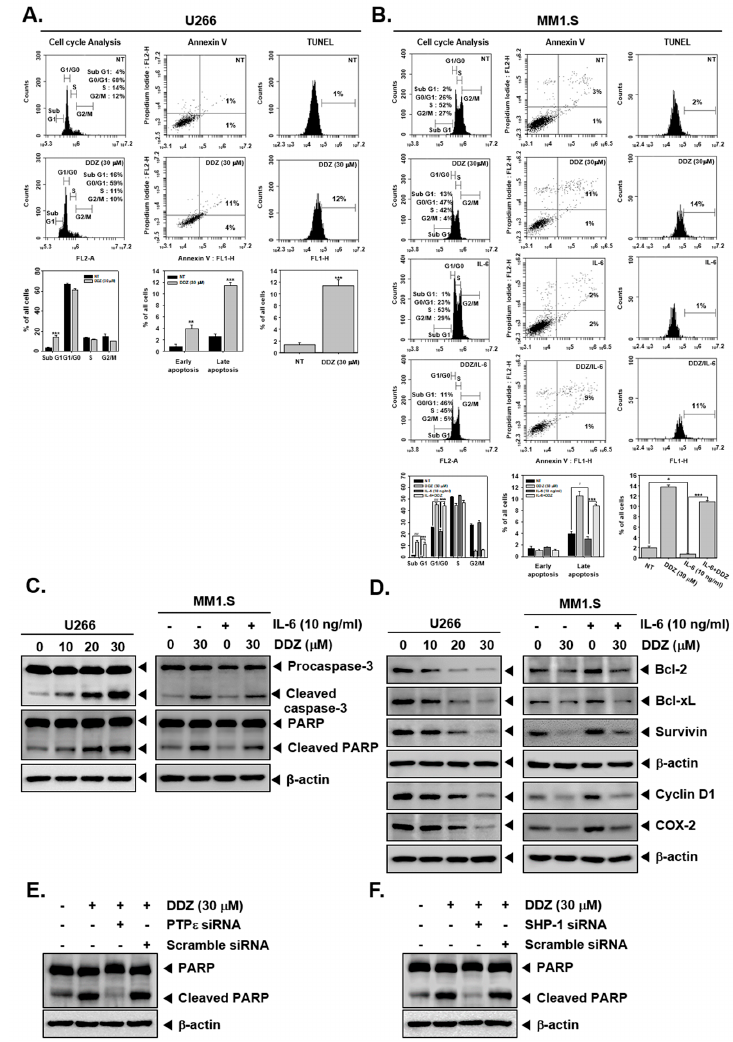
Figure 4. DDZ promotes apoptosis in multiple myeloma (MM) cells. ( A , B ) U266 cells were treated with 30 µ M of DDZ for 24 h, and MM1.S cells were treated with 30 µ M of DDZ for 24 h and stimulated with IL-6 (10 ng / mL) for 10 min. Cell cycle analysis: The cells were fixed with 100% ethanol, and cell cycle analysis was done using cytometry. Annexin V: cells were stained with Annexin V FITC and PI for 15 min before being analyzed by flow cytometry. TUNEL: The cells were fixed by 4% PFA (paraformaldehyde), stained with a TUNEL assay reagent, and analyzed with flow cytometry. The results are presented as the mean ± SD. ** p < 0.01, *** p < 0.001, # p < 0.05, ### p < 0.001 compared the control. ( C , D ) U266 cells (1 × 10 6 cells / well) were treated with indicated concentrations of DDZ for 24 h, and various proteins were examined by western blot analysis. MM1.S cells (1 × 10 6 cells / well) were treated with 30 µ M of DDZ for 24 h and stimulated with IL-6 (10 ng / mL) for 10 min. Then various proteins were examined by western blot analysis. ( E , F ) U266 cells (2 × 10 6 cells / well) were transfected